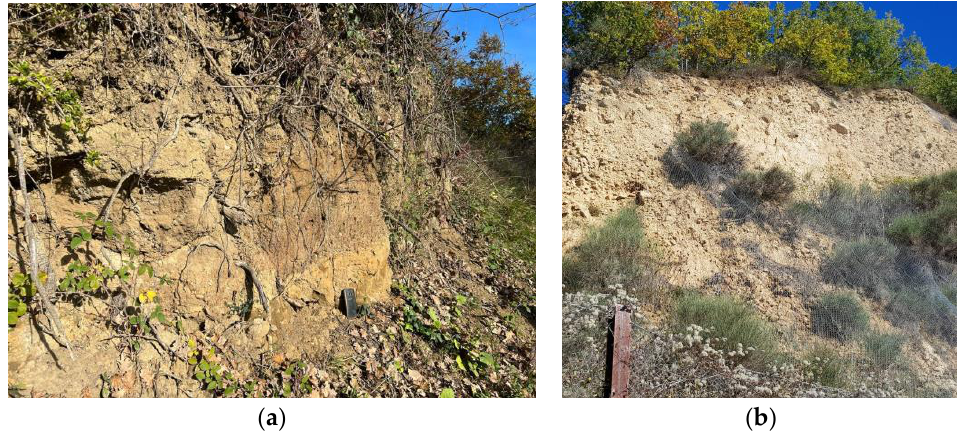
Figure 6. ( a ) Outcrops of sandy sediments in the southern part of the Montemurro; ( b ) conglomerates outcropping near the village. The site where the photos were taken is reported in Figure 4. (Photoes taken by Bentivenga M.)